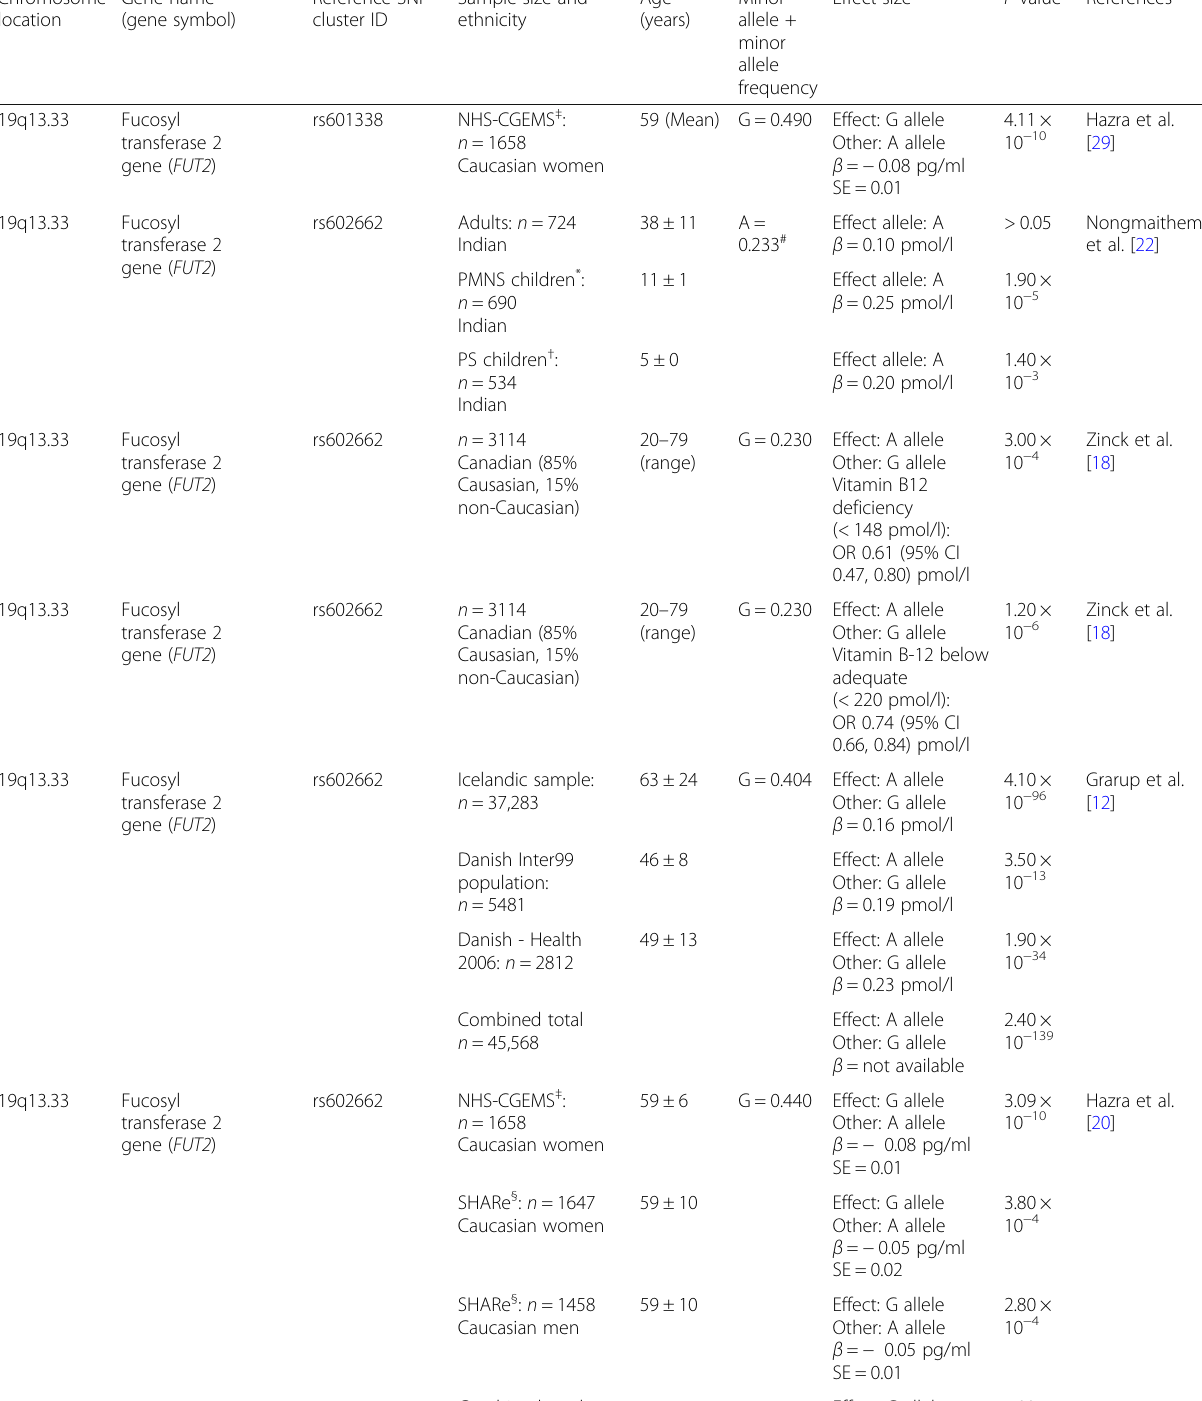
Table 1 Genome-wide association studies showing the association of SNPs with vitamin B12 concentrations. Genome-wide association studies testing the association between SNPs and vitamin B12 concentrations. The chromosome location, gene name, reference SNP cluster ID, sample size and ethnicity, mean age, observed frequency of the minor allele in the population, effect size and P value are shown in the table. The order of SNPs reflects the order of the chromosome location